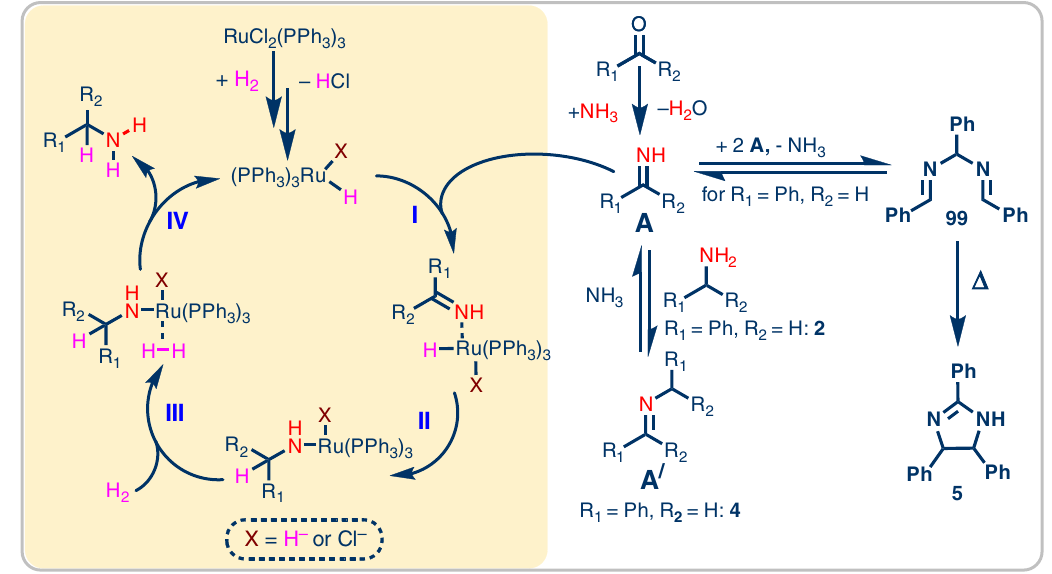
Fig. 8 Proposed reaction mechanism for the RuCl 2 (PPh 3 ) 3 -catalyzed reductive amination. A Unstable primary imine; A / stable secondary imine. 5 = 2,4,5-